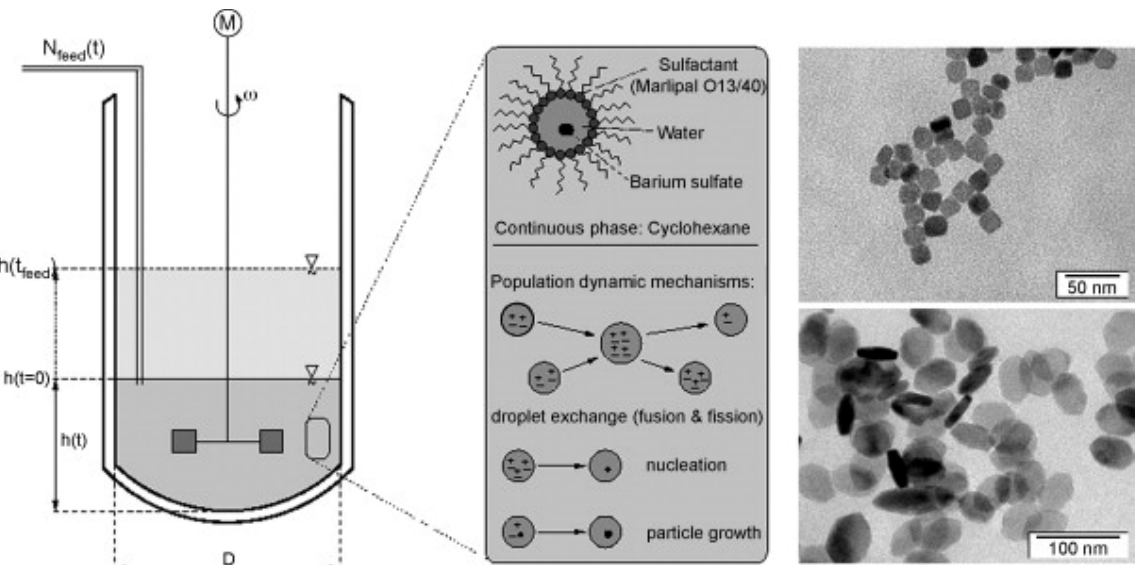
Figure 6. Process diagram, population dynamics, and TEM image of generated BaSO 4 NPs. Reprinted with permission from ref. [78]. Copyright 2008 Elsevier.